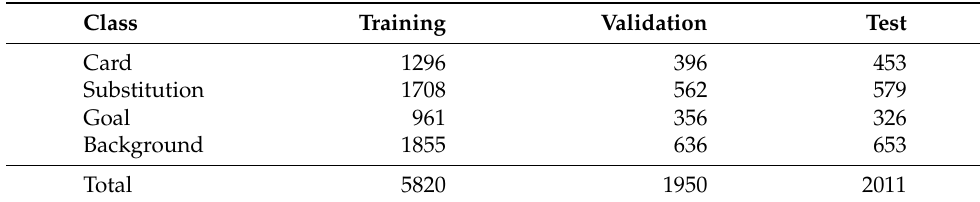
Table 1. The number of samples per class in our dataset.